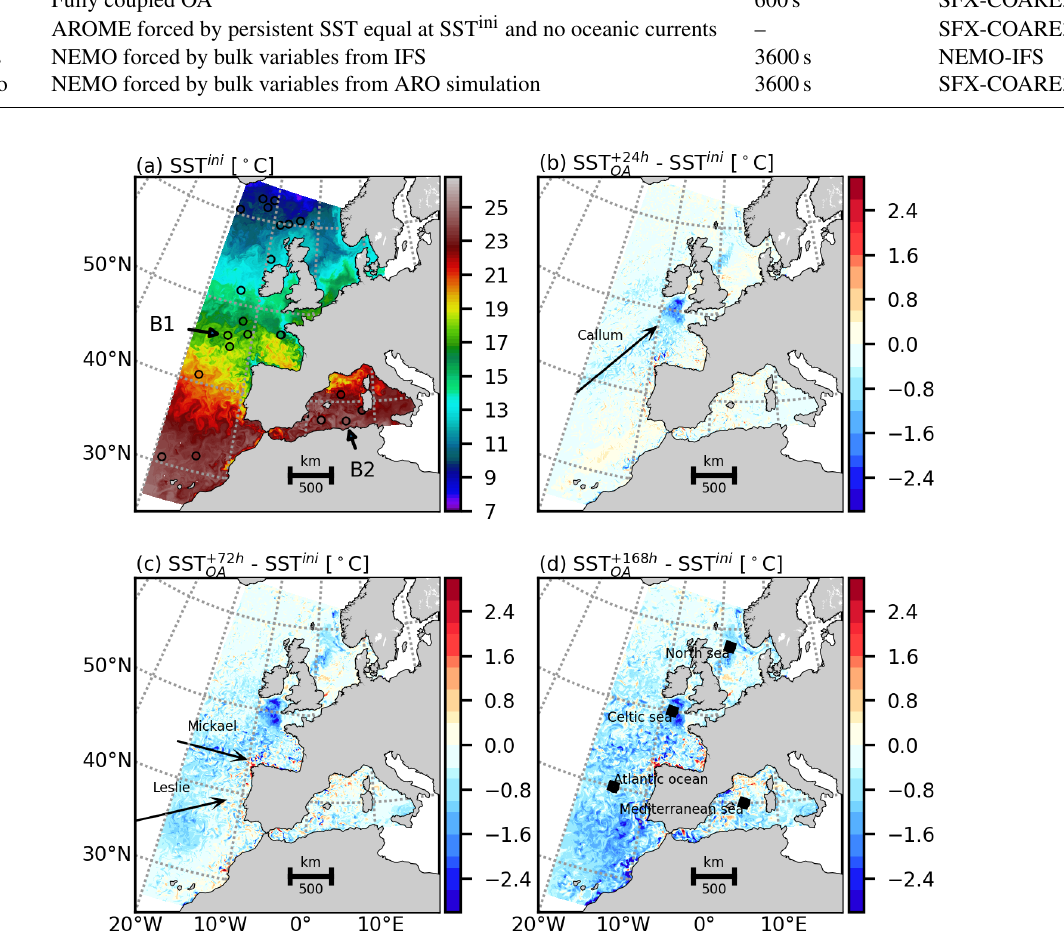
Figure 3. Initial SST (12 October 2018, 00:00UTC) (a) and evolution of the SST ( ◦ C) after 1d (b) , 3d (c) and 7d (d) in the coupled simulation (OA; Table 2). In (a) , the colour circles represent the SST measured by drifting buoys at that time ; B1 and B2 labels indicate the location of the two drifting buoys used in Fig. 5. Black squares in (d) correspond to four extracted areas used for analysis in the next subsections.